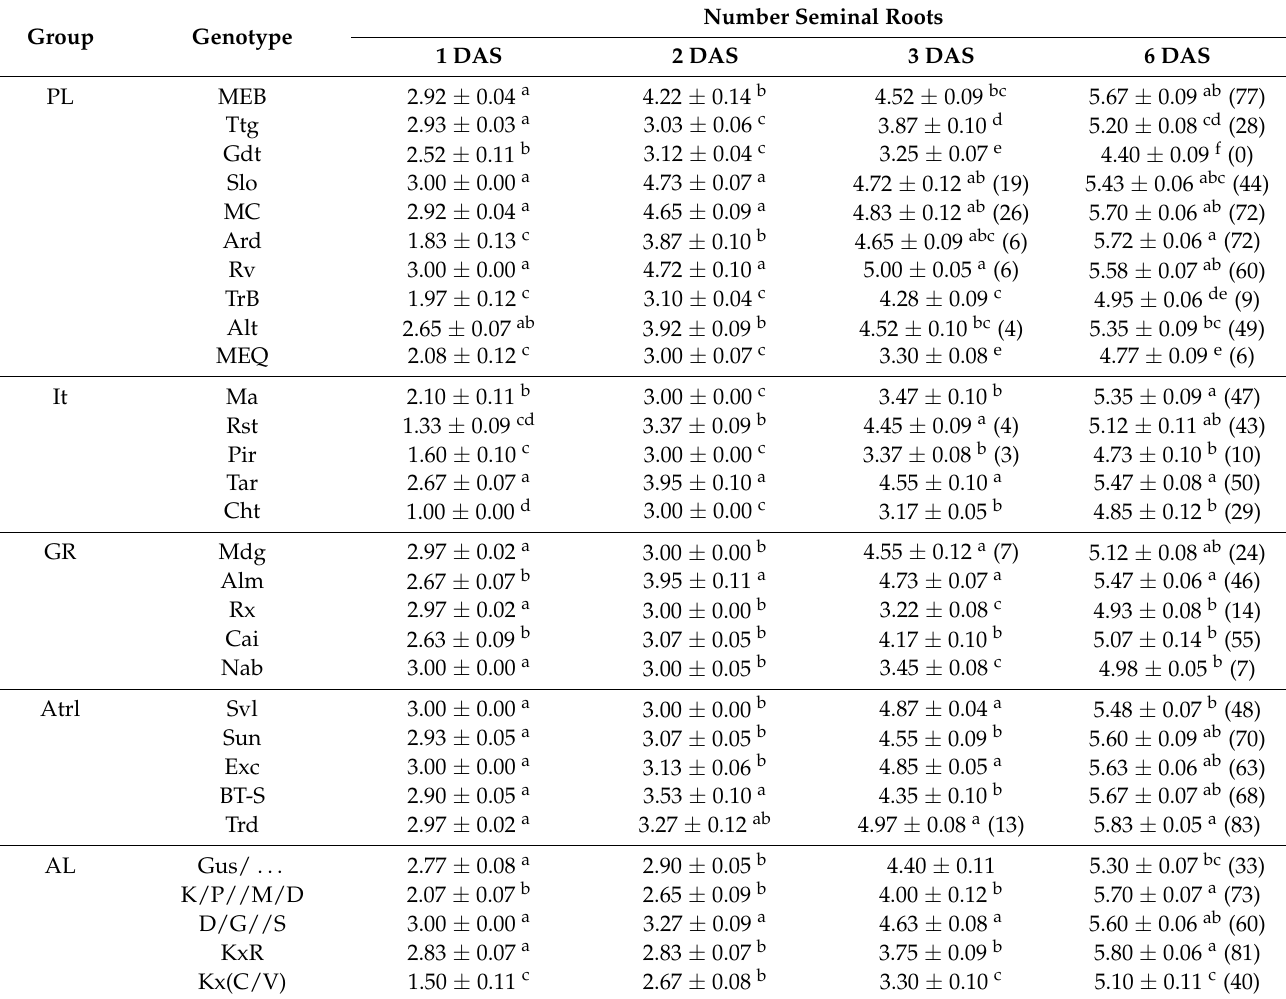
Table 2. Number of Seminal Roots (NSR) and percentage of 6th seminal root formation (in paren- thesis) at 1, 2, 3 and 6 days after sowing (DAS) of 30 bread wheat genotypes belonging to five evolutive/breeding groups. For each genotype, the mean values ± SE ( n = 24–60) followed by different letters express significant differences (a, b, c, d, e, f) for a 95% confidence level. The highest value corresponds to the letter a. PL—Portuguese Landraces; It—Italians; GR—Green Revolution; Atrl—Australians; AL—Advanced